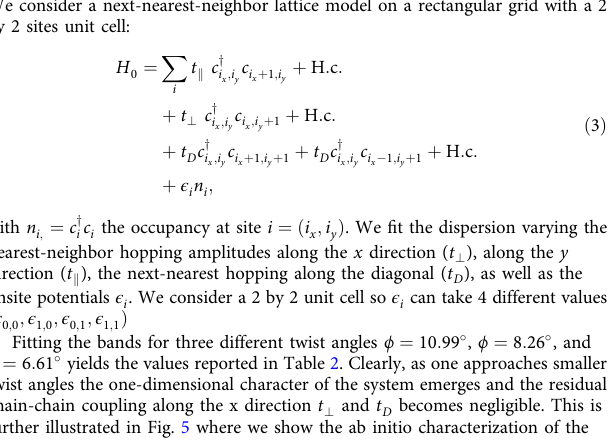
ϕ ¼ 6 : 61 (cid:1) yields the values reported in Table 2. Clearly, as one approaches smaller twist angles the one-dimensional character of the system emerges and the residual chain-chain coupling along the x direction t ? and t D becomes negligible. This is further illustrated in Fig. 5 where we show the ab initio characterization of the